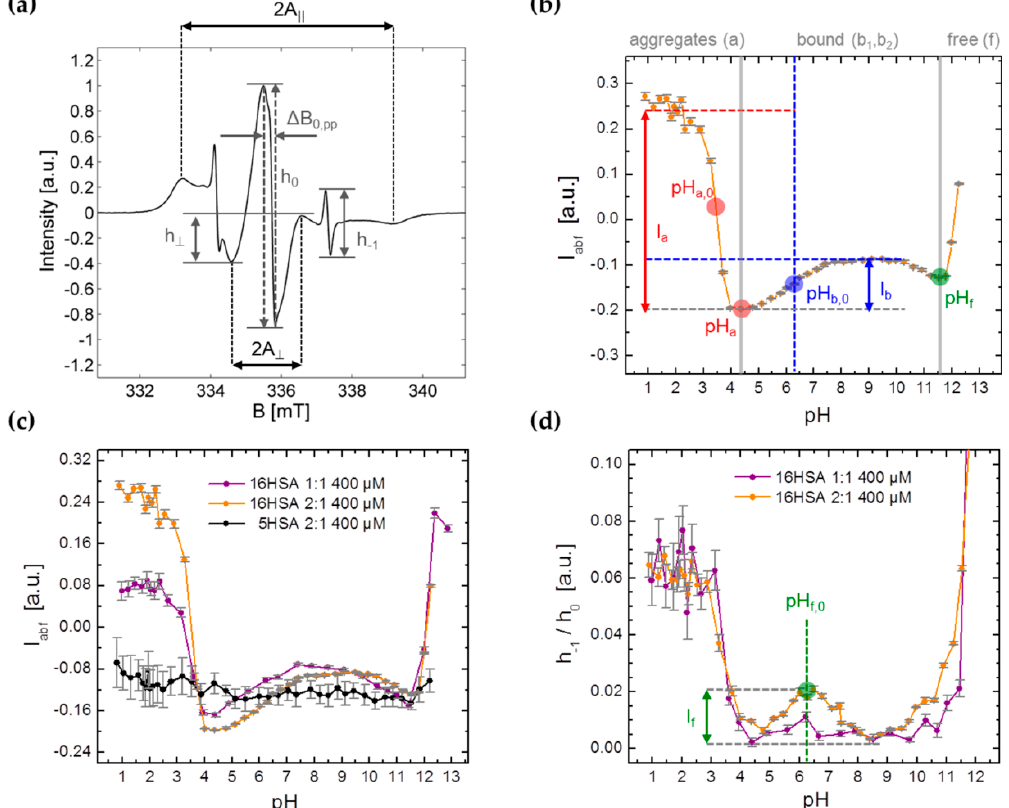
Figure 4. Lineshape readout scheme for spin probed HSA samples and the pH ‐ dependent I abf parameter. A scheme is presented that traces characteristic changes in CW EPR spectra from spin probed HSA solutions with pH. ( a ) A representative spectrum of 16 ‐ DSA ‐ probed HSA (2:1) at 400 μ M equivalents is shown for pH 12.24. Vertical parameters are the center ‐ field peak height ( h 0 ), high ‐ field peak height ( h –1 ) and the intensity shift h ﬩ . The horizontal parameters are A || , A ﬩ and the center ‐ field peak width ( Δ B 0,pp ) that are used in this study (see below). ( b ) An I abf parameter analysis